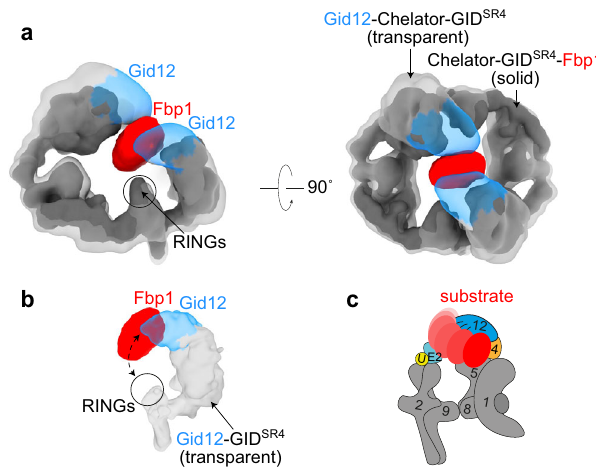
Fig. 4 Gid12 fully and partially obstructs substrate placement in Chelator-GID SR4 and GID SR4 assemblies, respectively. a Superposition of 3D reconstructions of Gid12-Chelator-GID SR4 (transparent gray, with Gid12 in blue) and Chelator-GID SR4 -Fbp1 (solid gray, with substrate Fbp1 in red) shows that Gid12 fi lls much of the central region of Chelator-GID SR4 that encapsulates the globular domain of the recruited Fbp1 substrate. b Superposition of 3D reconstruction of Gid12-GID SR4 with the corresponding region of the map of Chelator-GID SR4 -Fbp1. The relatively open structure of GID SR4 does not encapsulate Fbp1, whose globular domain may thus occupy various relative positions between the Pro/N- degron recruited to Gid4 and RING-based catalytic module. c Cartoon representation showing how GID SR4 could dynamically accommodate various orientations of Fbp1 between Gid4 and RING-activated Ubc8~ubiquitin intermediate, some of which could be compatible with Gid12 bound to